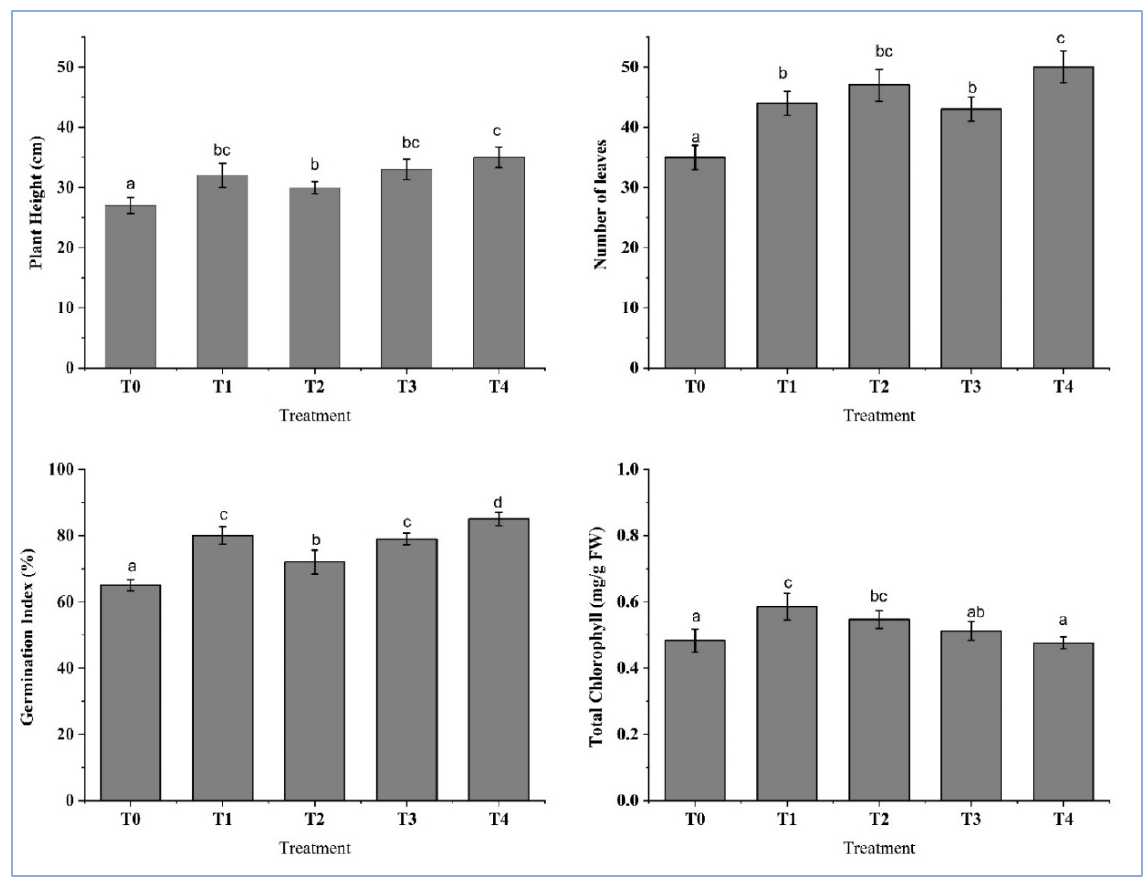
Figure 7. Effects of isolates inoculation on plant growth including PH, LN, GR, and TC content in S. lycopersicum plants. Error bars represent Means ± S.D of three replicates. Different letters above columns indicate statistically significant differences at p ≤ 0.05.